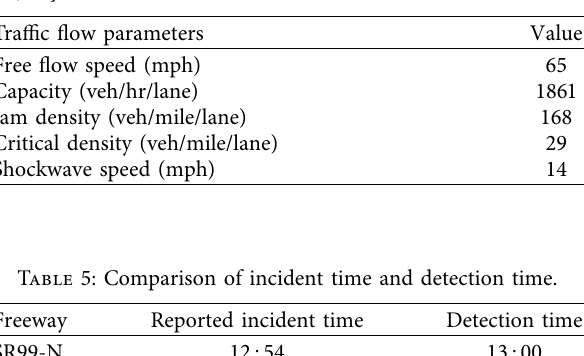
Table 4: PEMS calibrated fundamental diagram parameters [40, 41].